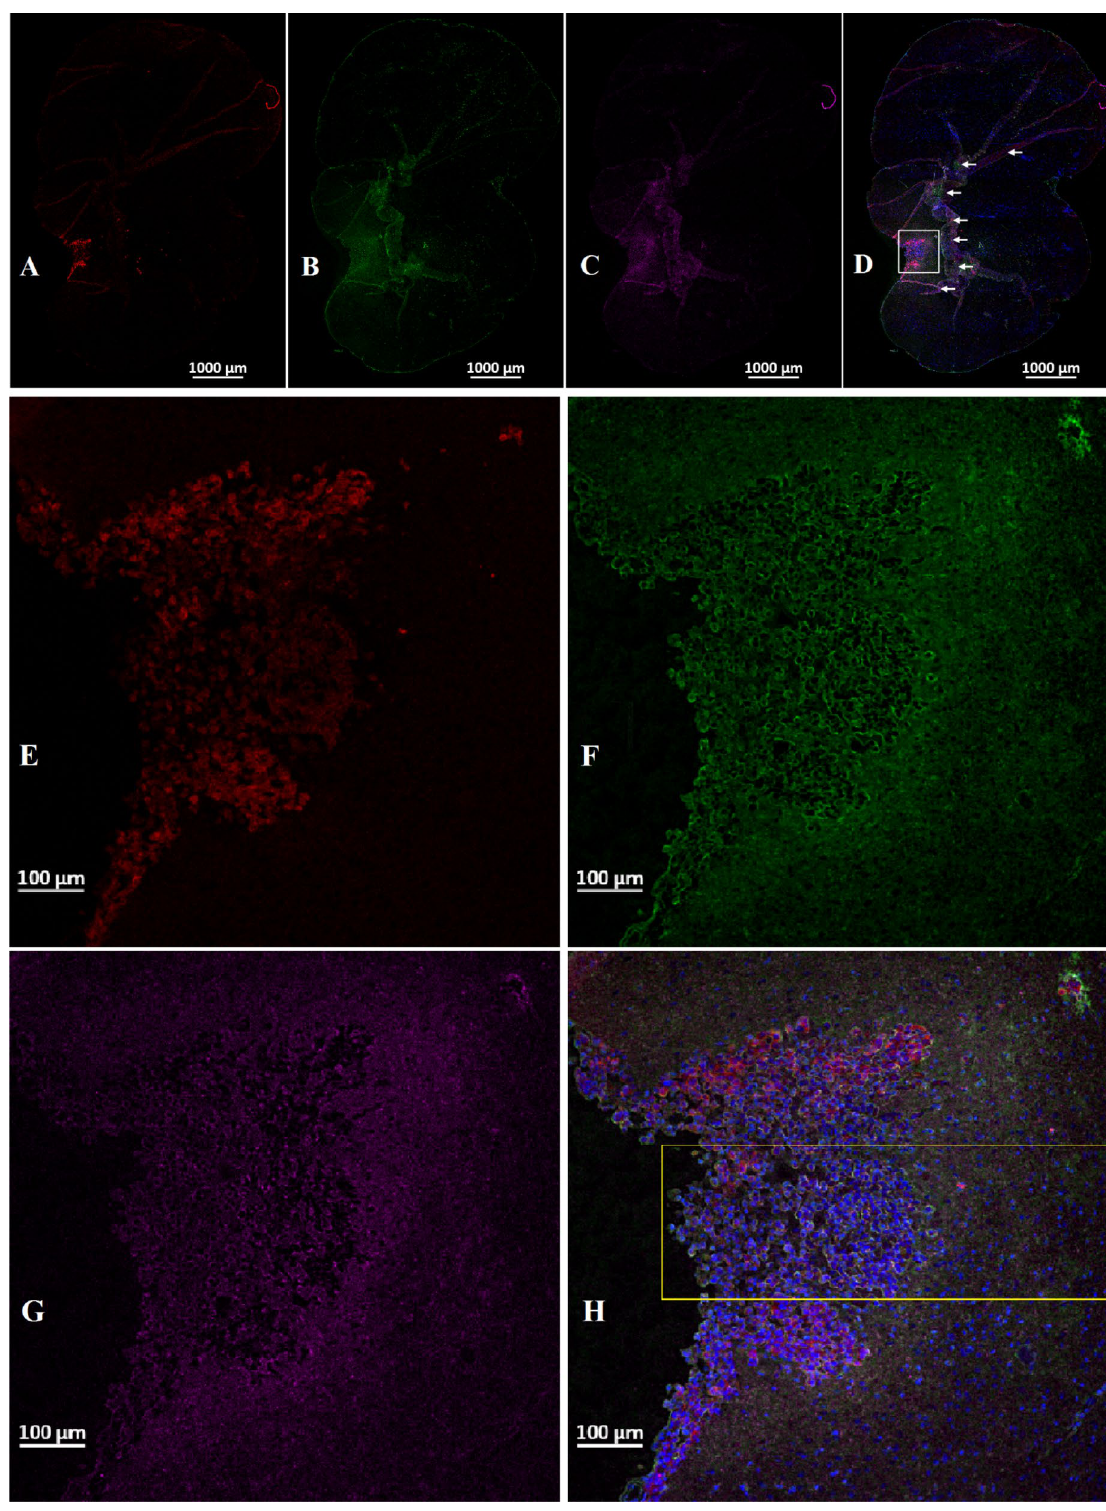
Figure 1. Confocal images (10 ×) of brain coronal sections ( A – H ) with advanced MBD-MD-231 tumors 24 h after iv INP injections. A – D , 10 × images of tumor residing in left-hemisphere; E–H, tumor and peritumor region in white square in D is magnified in ( E – H ). Nuclei (dapi = blue); A , E , Tumor cells (td-Tomato, red); B , F , INPs (anti-PEG, green); C , G , CD31 (antiCD31, violet); D , H . (all four channels). White arrows, some artefactual folds that formed during the preparation of the section. INPs are seen to be taken up mostly in the tumor and peritumor region where they mostly colocalize with CD3, nominally an endothelial